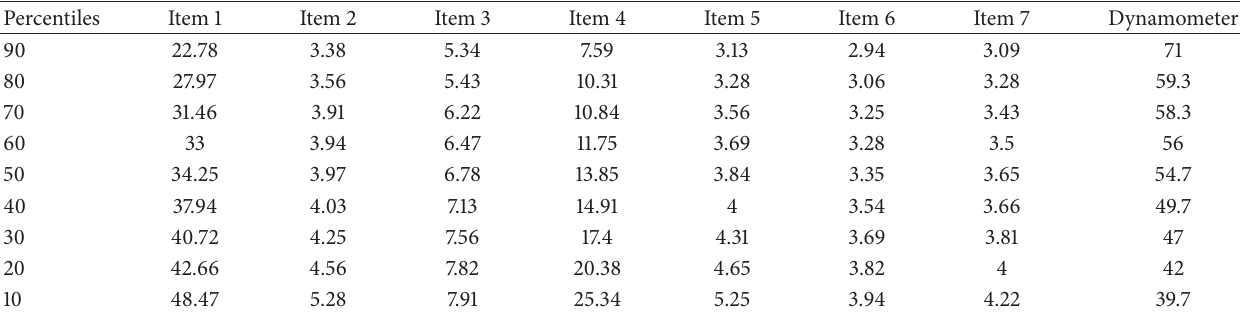
Table 9: 𝑛 = 19 ; males, 6–19, nondominant hand, educational instruction: elementary school.